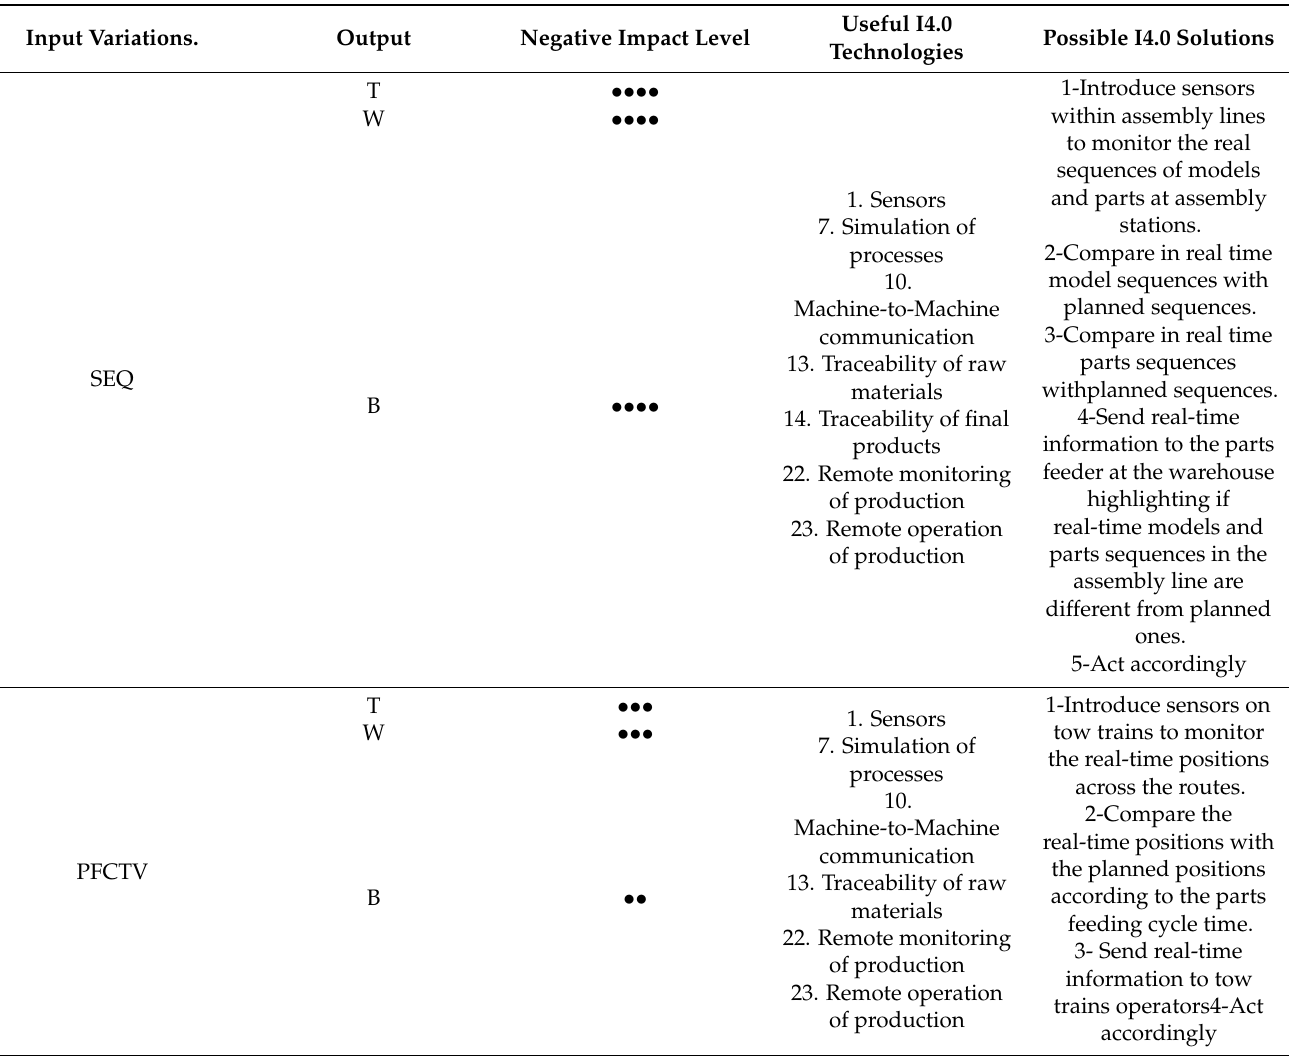
Table 4. Summary of the negative impact level of the variations of the input over the output parameters and possible solutions enabled by the adoption of Industry 4.0